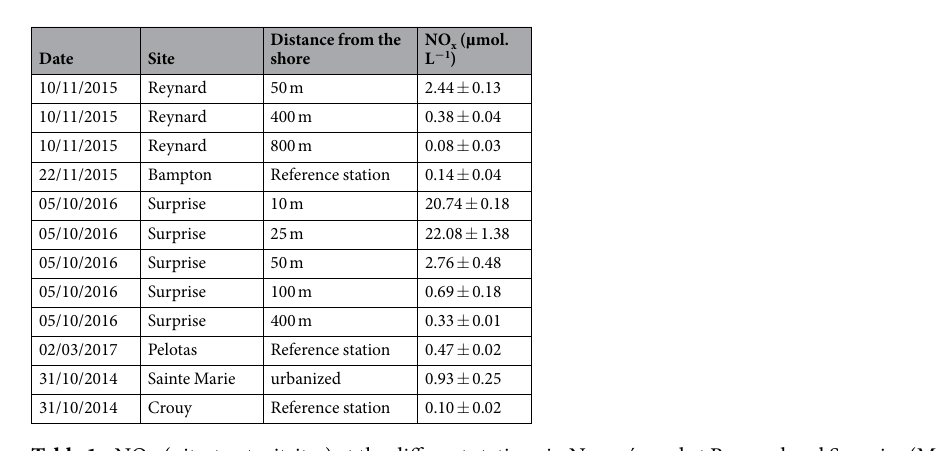
Table 1. NOx (nitrates + nitrites) at the different stations in Nouméa and at Reynard and Surprise (Mean ± SD, N = 3 per station). Reference stations were sampled at 50 m from the reef